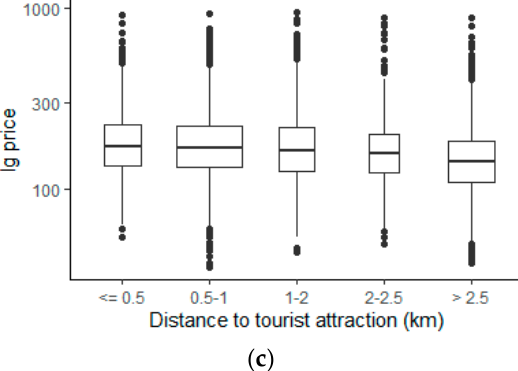
Figure 2. ( a ) Relationship between the number of pictures posted and accommodation prices. ( b ) Relationship between cities and accommodation prices. ( c ) Relationship between the distance to tourist attractions and accommodation prices.